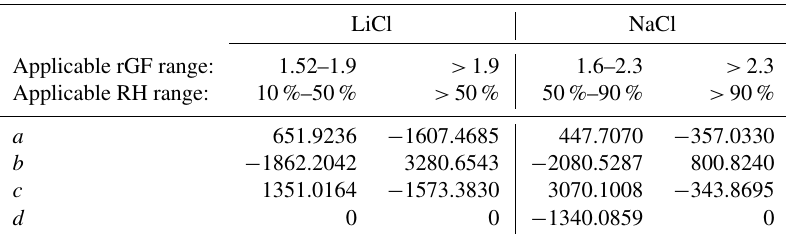
Table 2. Polynomial coefficients describing the RH as a function of radial GF for LiCl and NaCl in low- and high-RH regimes using the 3 − 1 polynomial RH = a + bx + cx 2 + dx 3 , where x = rGF . The GF is determined assuming the deliquescence RH of NaCl is 75.5% with an rGF 3 rGF of 1.90, and the deliquescence RH of LiCl is 11.3% with an rGF of 1.525.